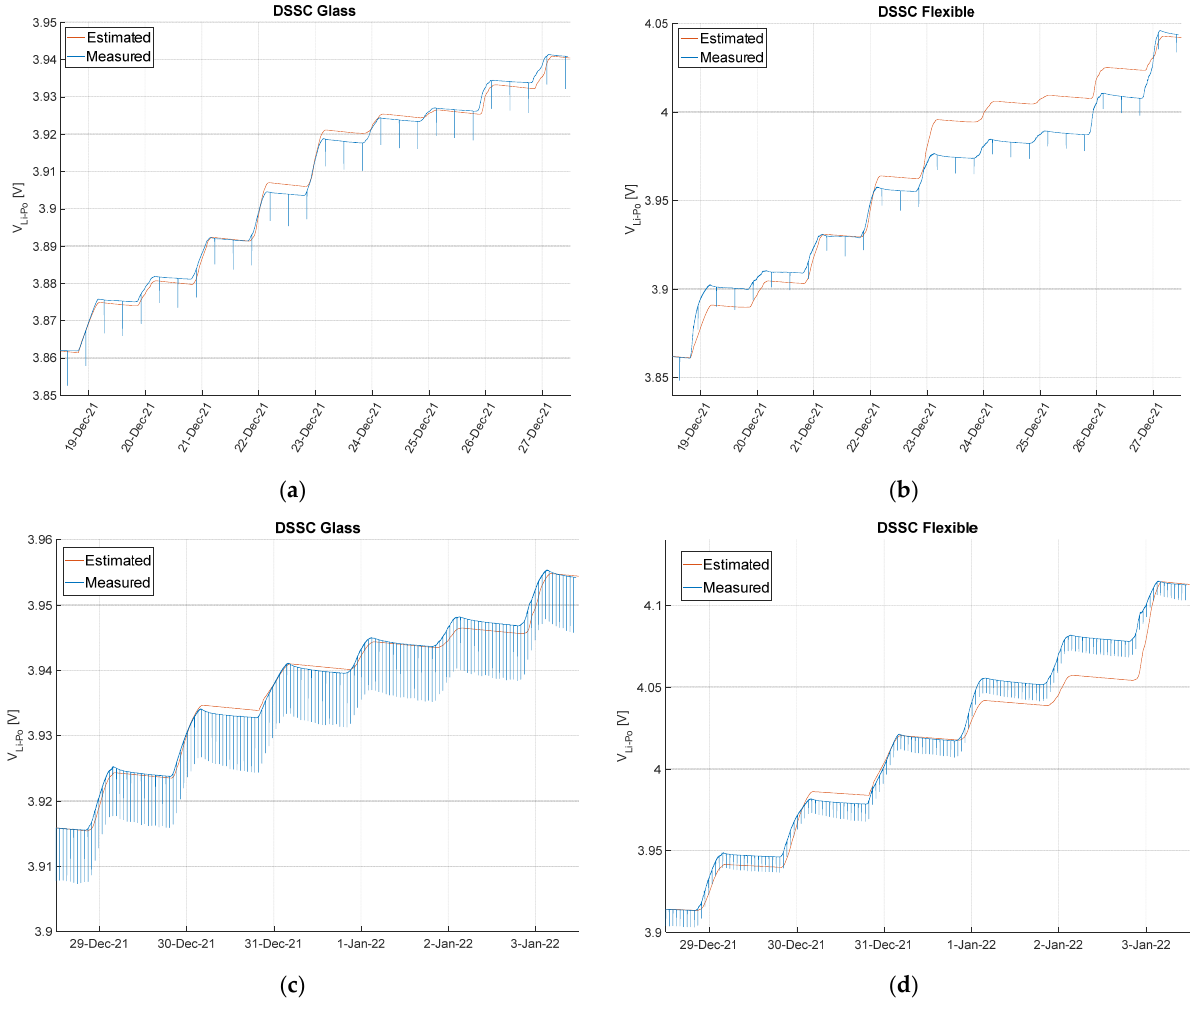
Figure 8. Acquired Li ‐ Po battery voltages of glass DSSC and flexible DSSC (blue plots) as well as battery voltages derived by calculating the charge delivered to the systems (red plots) during the first test campaign (( a , b ), respectively) and the second test campaign (( c , d ), respectively), starting from diffuse radiation intensity of Figure 7b,d.